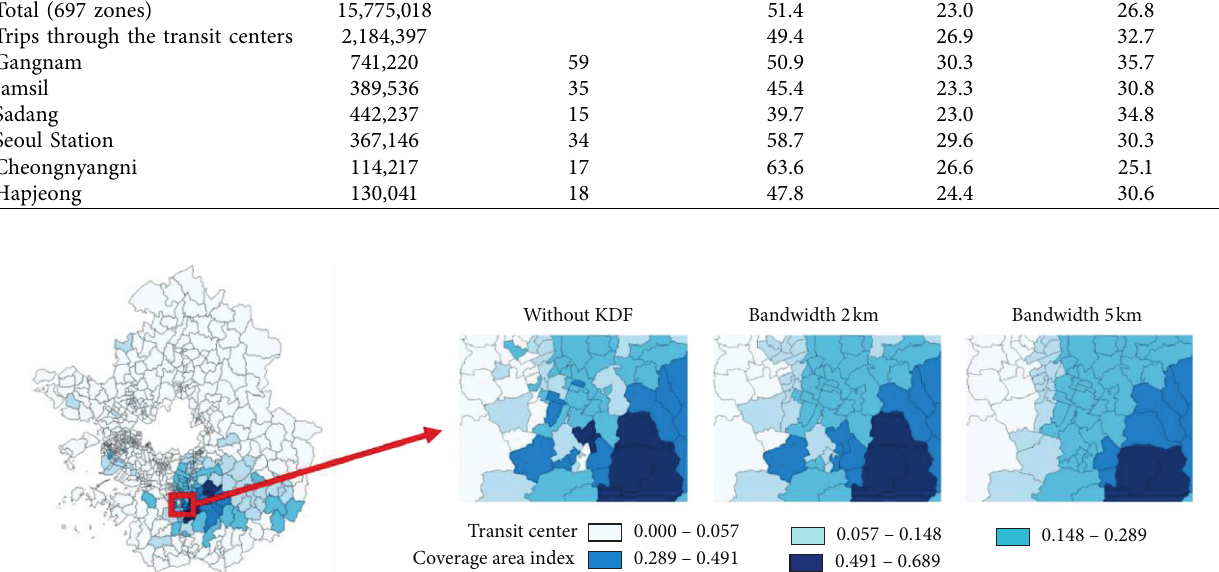
Figure 2: Study area: (a) outline of the Seoul metropolitan area; (b) transit centers used in the analysis. Table 1: Basic statistics of the obtained trip chain data between suburban zones and Seoul. Division